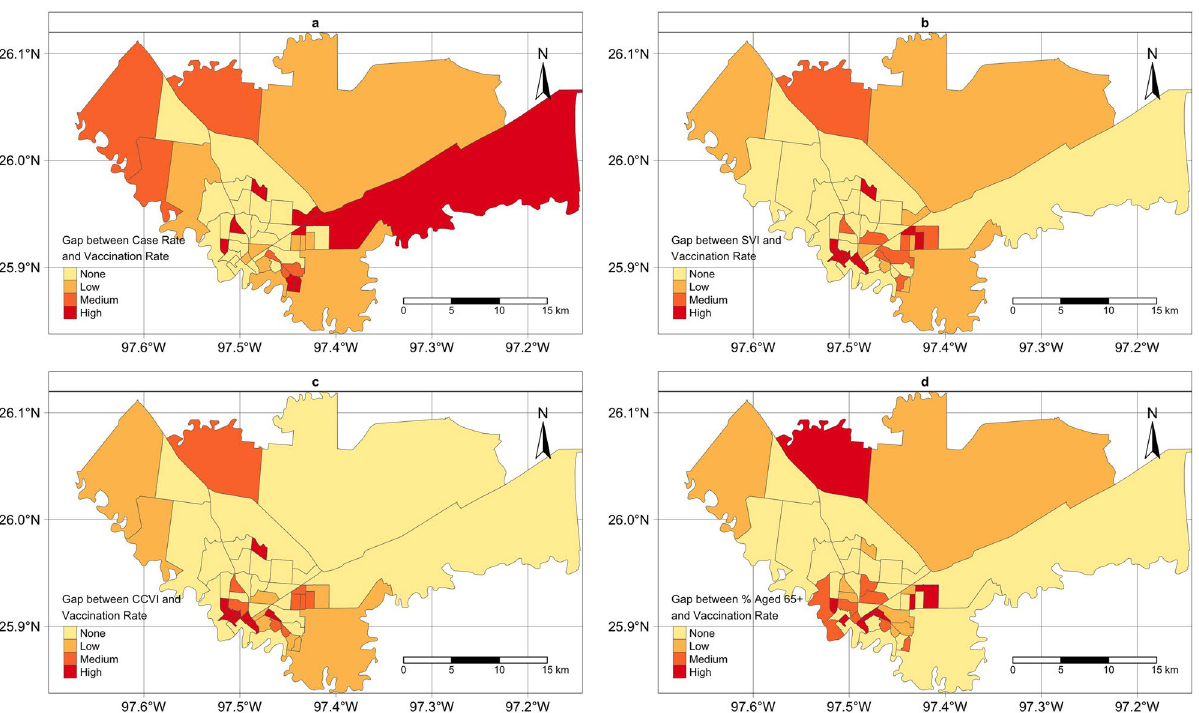
Figure 2. Maps of census tracts identified with no-gap/low/median/high vaccination gap in City of Brownsville, TX. Each panel corresponds to a different approach when assessing the gap proposed in this analysis. The choropleth maps were created by the authors using R studio (version 1.2.1335). URL http:// www. rstud io. com/ , and R package